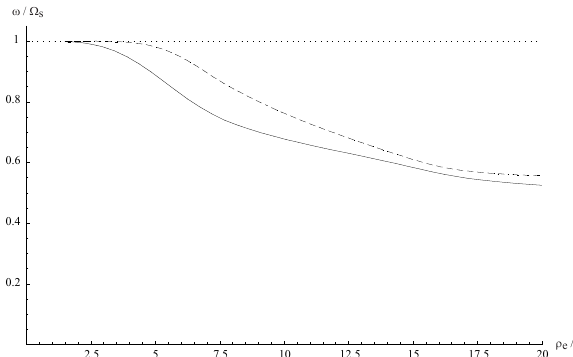
Figure 2 Fig. 2. Plot of the model (ω/(cid:127) S ) profiles mapped along field lines into the equatorial plane and shown as a function of radial distance ρ e from the planet, normalised to the value of Saturn’s radius taken here to be equal to 60330km. The solid line is the large-scale model for Voyager-1 (with small-scale features considered in the companion paper by Cowley and Bunce (2003) omitted), while the dashed line is the corresponding model for Voyager-2. The dotted line shows the condition for rigid corotation, i.e. (ω/(cid:127) S ) = 1.